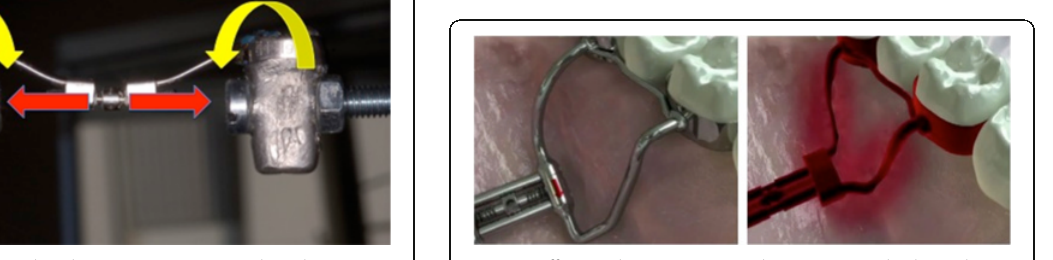
Fig. 14 Difference between RPEs with arms perpendicular and parallel to the guides